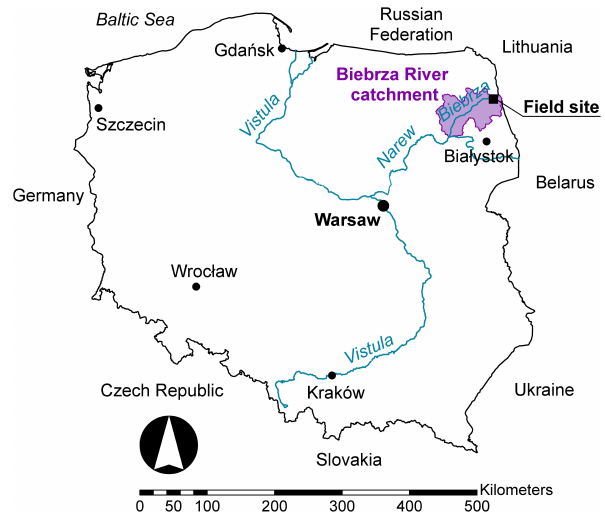
Fig. 1. Location of the Biebrza River catchment in